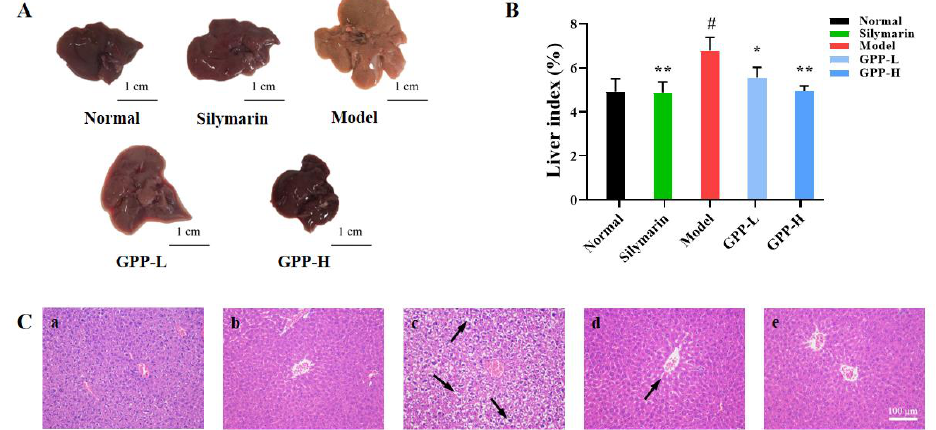
Figure 5. ( A ) Appearance of liver tissues. ( B ) Liver index of the different groups. ( C ) Histopatho- logical evaluation of liver tissues, stained with H&E (200×): (a) normal group; (b) positive group, pretreatment with silymarin; (c) model group; (d,e) GPP-treated groups at different concentrations of GPPs (100 mg/kg and 200 mg/kg). The black arrow indicates hepatic cell necrosis and vacuoli- zation. Compared with model group, * in the same column indicates significant difference ( p < 0.05). Compared with the normal group, # means significant difference ( p < 0.05). Values are presented as means ± SDs ( n =